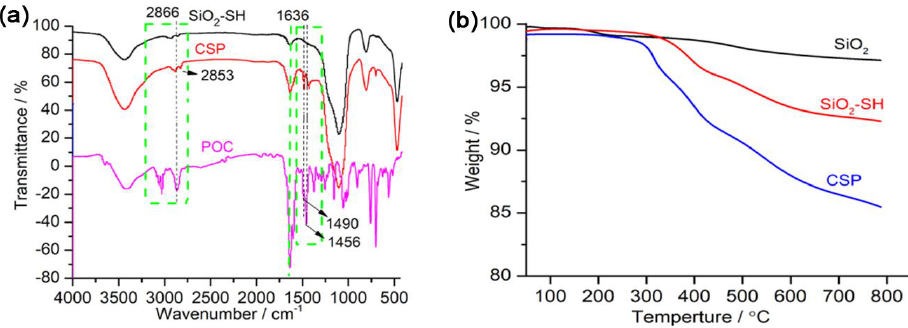
Figure 2. ( a ) FT–IR spectra obtained for the prepared chiral POC, SiO 2 –SH, and CSP. ( b ) TGA curves of the SiO 2 , SiO 2 –SH, and CSP.